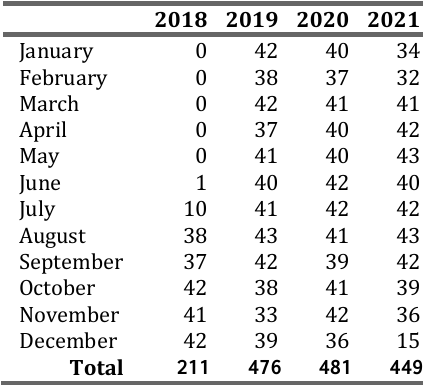
Table 1. Number of images per year and